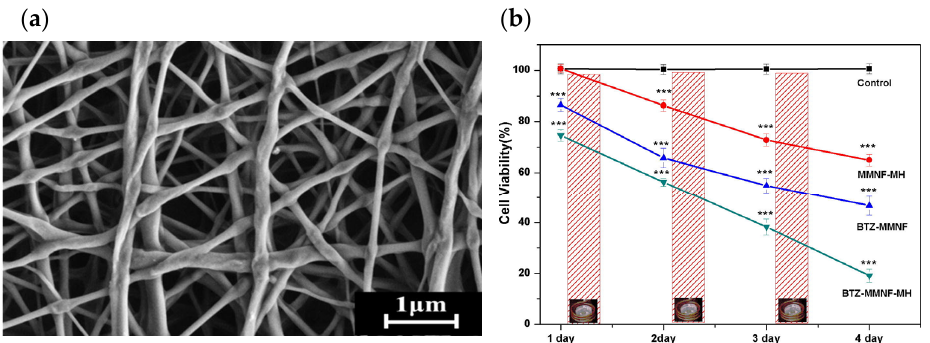
Figure 9. ( a ) FESEM image of electrospun PLGA nanofibres and MNF; ( b ) Anticancer effects of MMNF ‐ MH (hyperthermia alone), BTZ ‐ MMNF (drug alone) and BTZ ‐ MMNF ‐ MH (hyperthermia with drug ‐ loaded magnetic nanofibre) on 4T1 cell lines under repeated application of hyperthermia on days 1, 2, and 3. (Asterisks indicate a significance in toxicity using ANOVA test [*** p < 0.001]) Reprinted/adapted with permission from Ref. [69]. 2016, Elsevier.